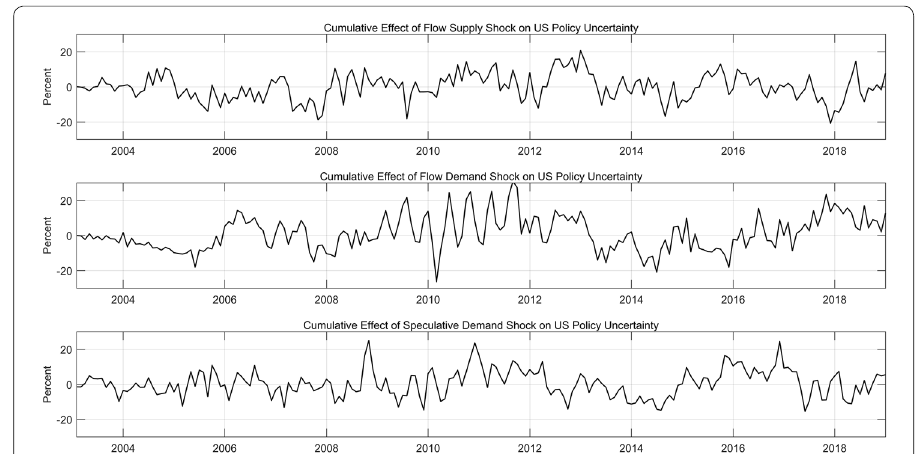
Fig. 6 Historical decomposition of oil supply and demand shocks to economic policy uncertainty: 2003:01 to 2018:12. Notes: The figure shows the cumulative effects of oil supply and demand shocks on the economic policy uncertainty, using the economic policy uncertainty index and the real stock returns of the clean industry in the VAR